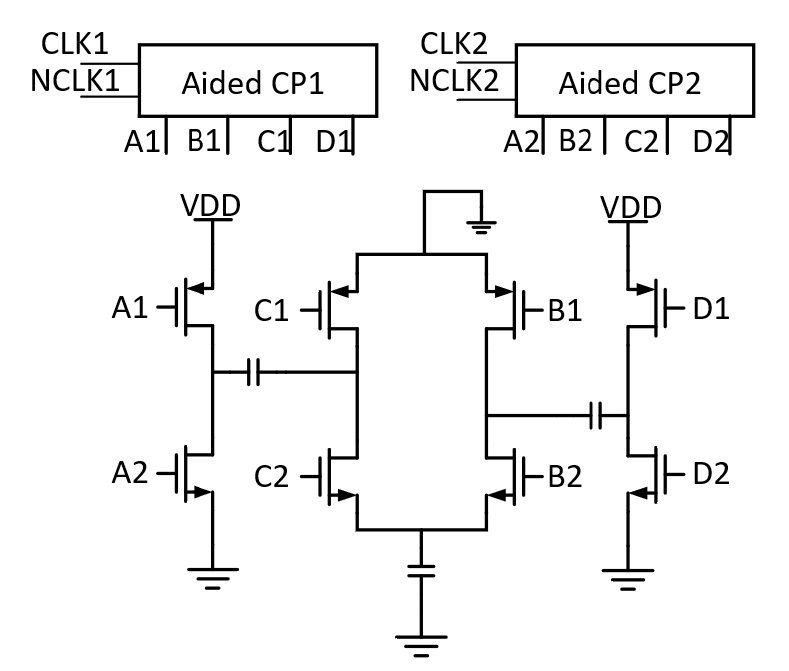
Figure 6. The circuit of proposed